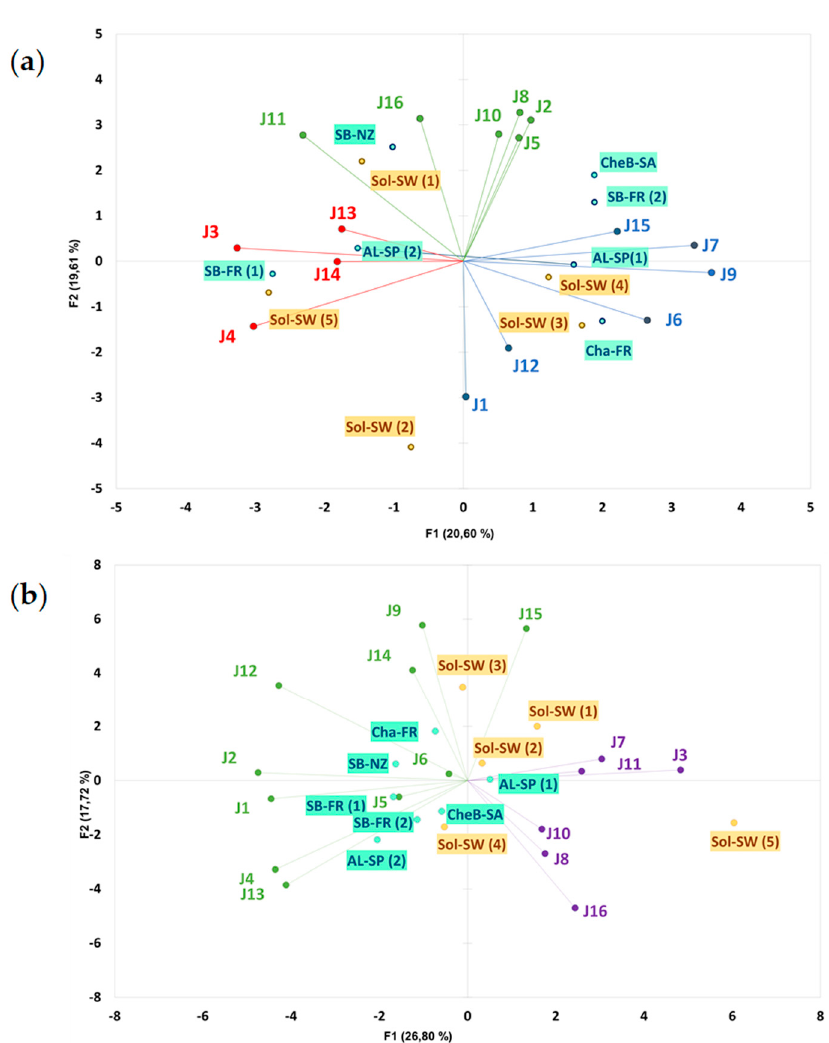
Figure 1. ( a ) Principal Component Analysis (PCA) Biplot representing the consensus between judges (J1-J16) according to their typicality scores. ( b ) PCA Biplot representing the consensus between judges (J1-J16) according to their quality scores.